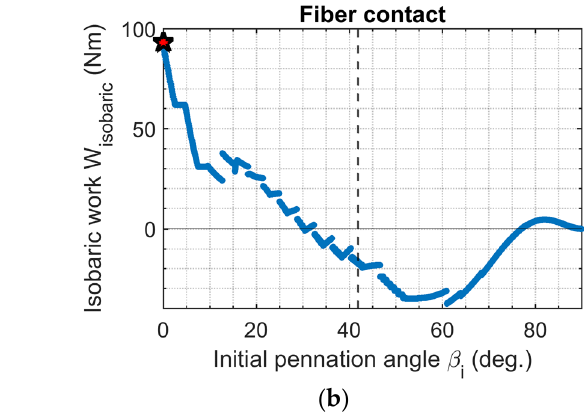
Figure 17. Variation in isobaric work output capacity with initial pennation angle for ( a ) pinned boundary condition and ( b ) fiber contact boundary condition. The red star indicates a parallel ( β i = 0 ◦ ) muscle bundle topology, and dashed vertical line indicates the boundary between fiber contraction-limited (left of the line) and fiber rotation-limited (right of line) topologies.